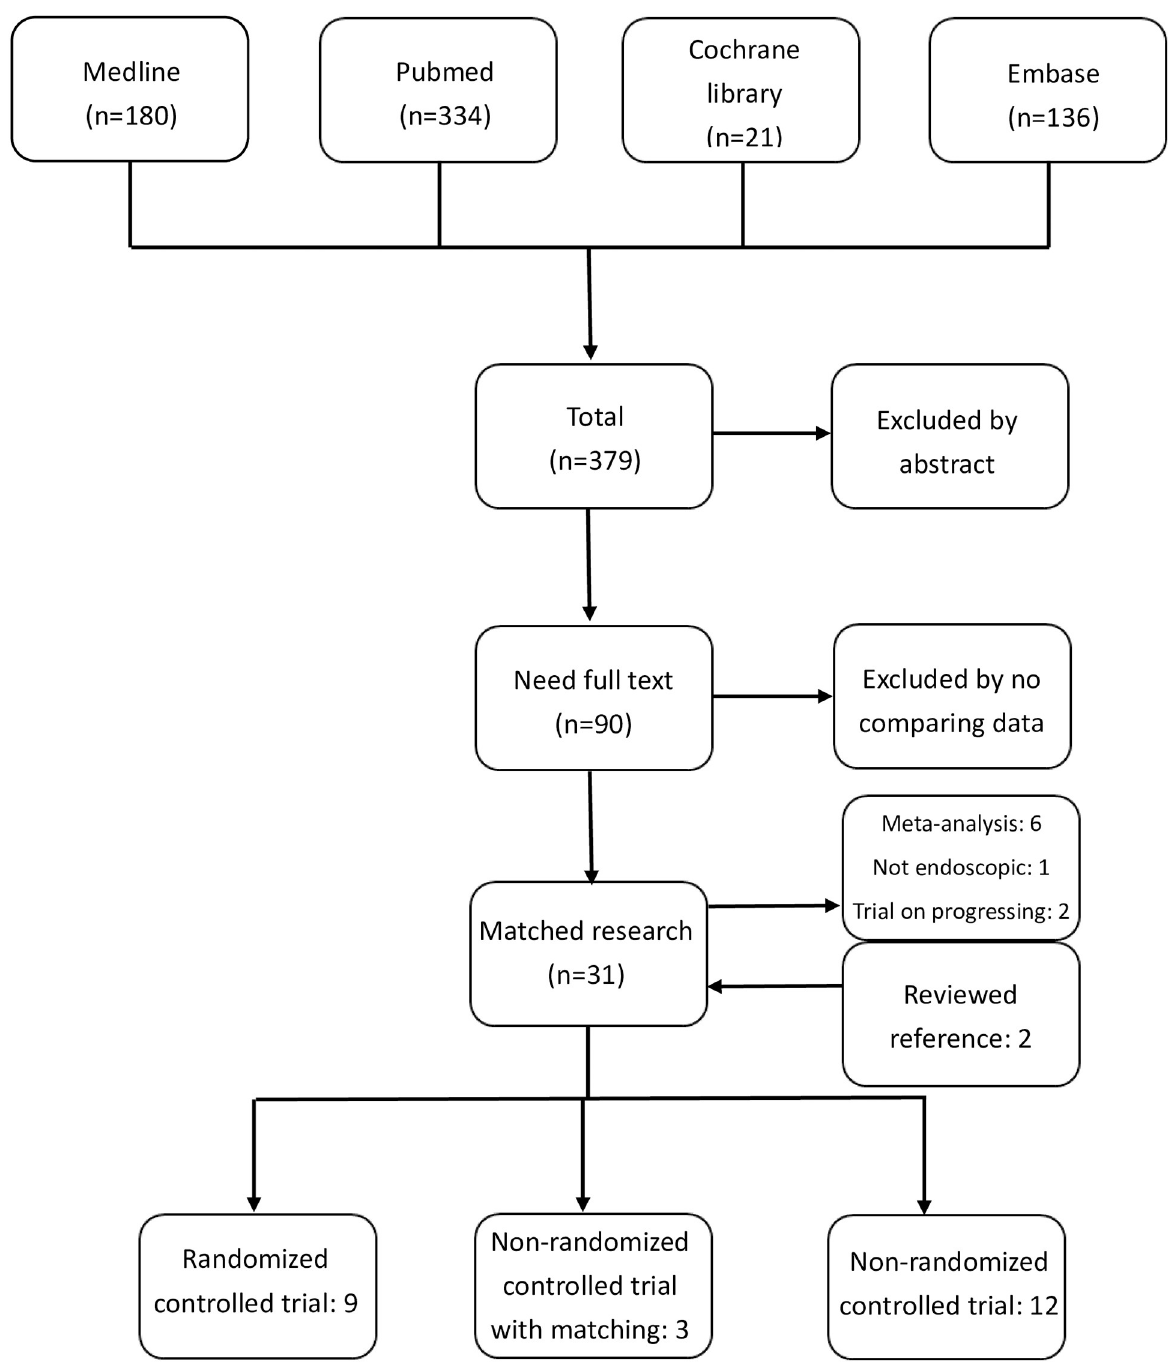
Fig 1. Study searching flow